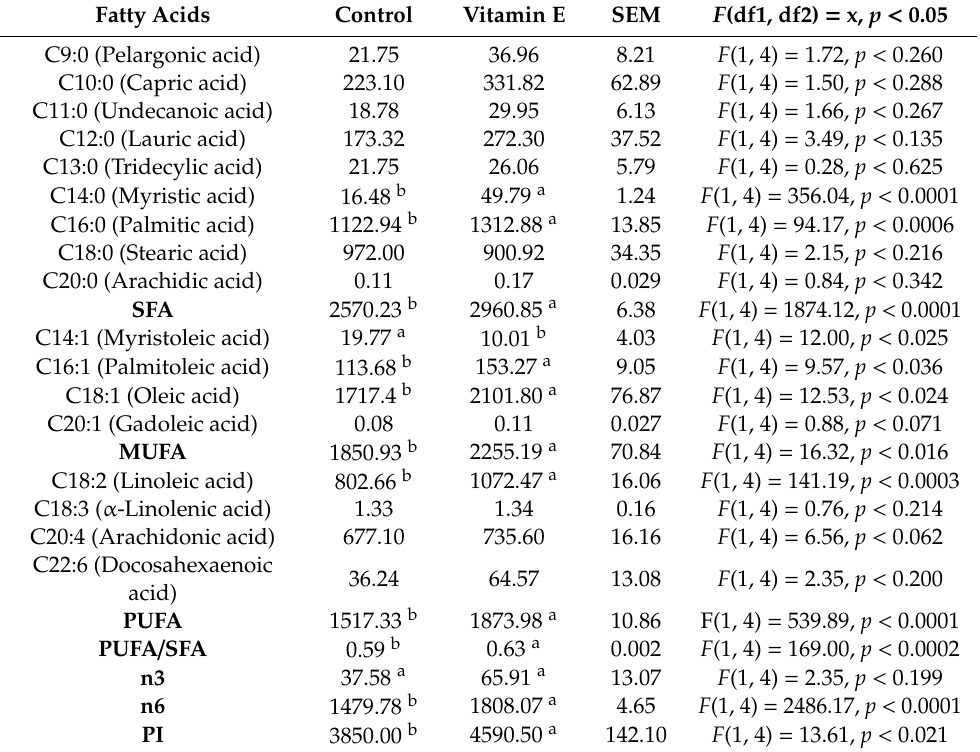
Table 6. E ff ect of vitamin E supplementation on the fatty acid composition (mg fatty acid / 100 g meat) of goose